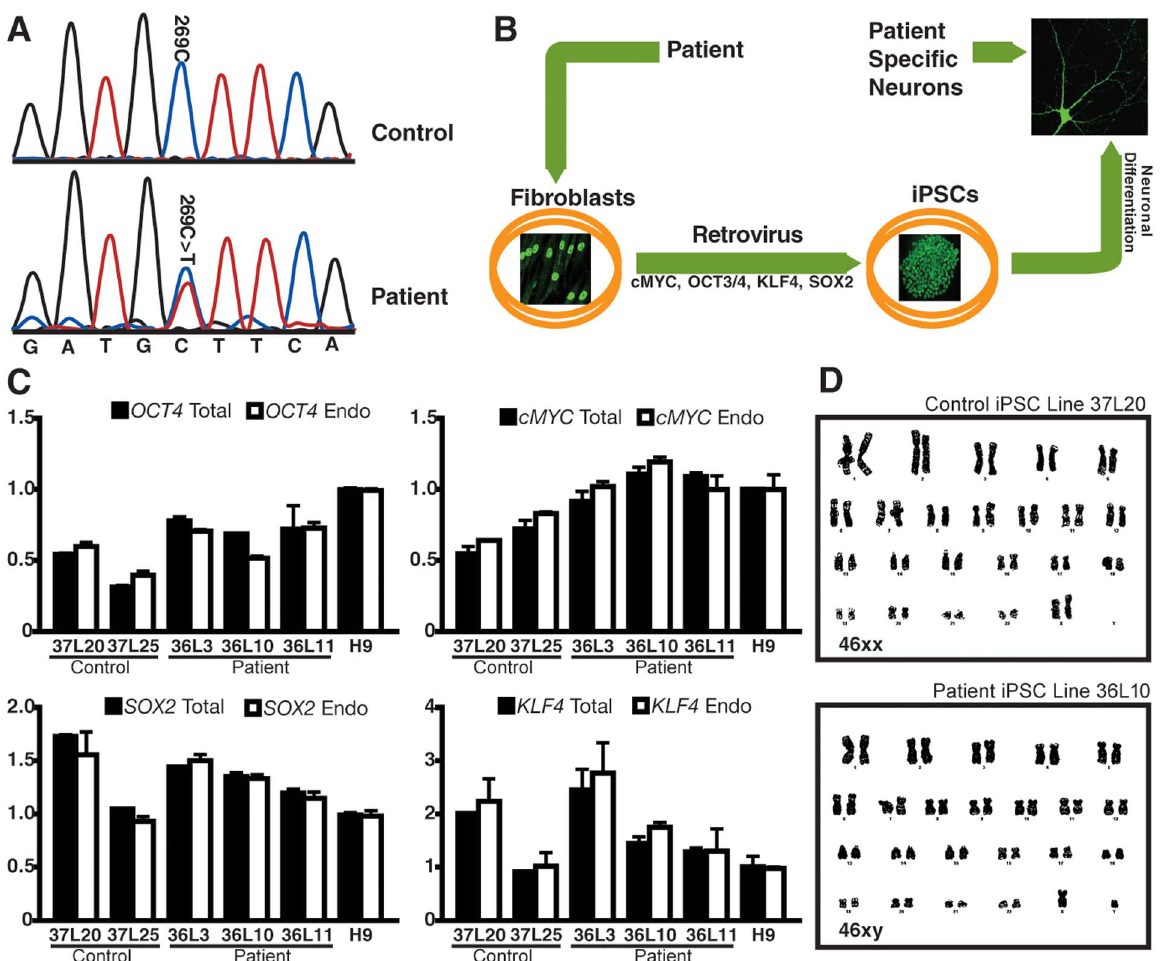
Figure 1. Generation and characterization of FTD/ALS patient-specific iPSC lines with the TDP-43 A90V mutation. ( A ) Sequencing of genomic DNA from patient fibroblasts confirmed the presence of the missense TDP43 A90V (c.269 C . T) mutation. ( B ) Schematic representation of the steps from the collection of patient fibroblasts to the derivation of postmitotic neurons. Fibroblasts, iPSCs and neurons were immunostained with TDP-43, NANOG and TUJ1 antibodies, respectively. ( C ) Quantitative RT-PCR analysis of the levels of total and endogenous expression of OCT4 , CMYC , SOX2 , and KLF4 in iPSC and H9 ESC lines. Values were normalized to GAPDH levels. ( D ) No chromosomal abnormalities were found in any of the selected iPSC lines. The karyotypes of control line 37L20 and patient line 36L10 are